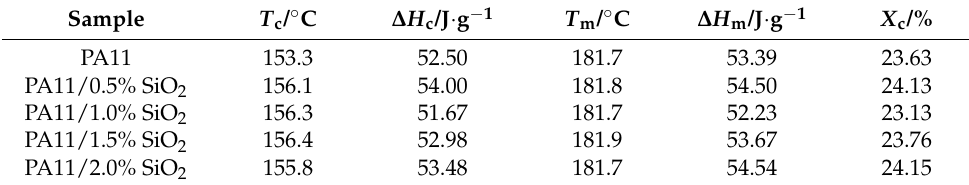
Figure 5. DSC curves of PA11/SiO 2 composites: ( a ) crystallization curve, ( b ) melting curve. Table 1. DSC thermodynamic parameters of PA11/SiO 2 composites.